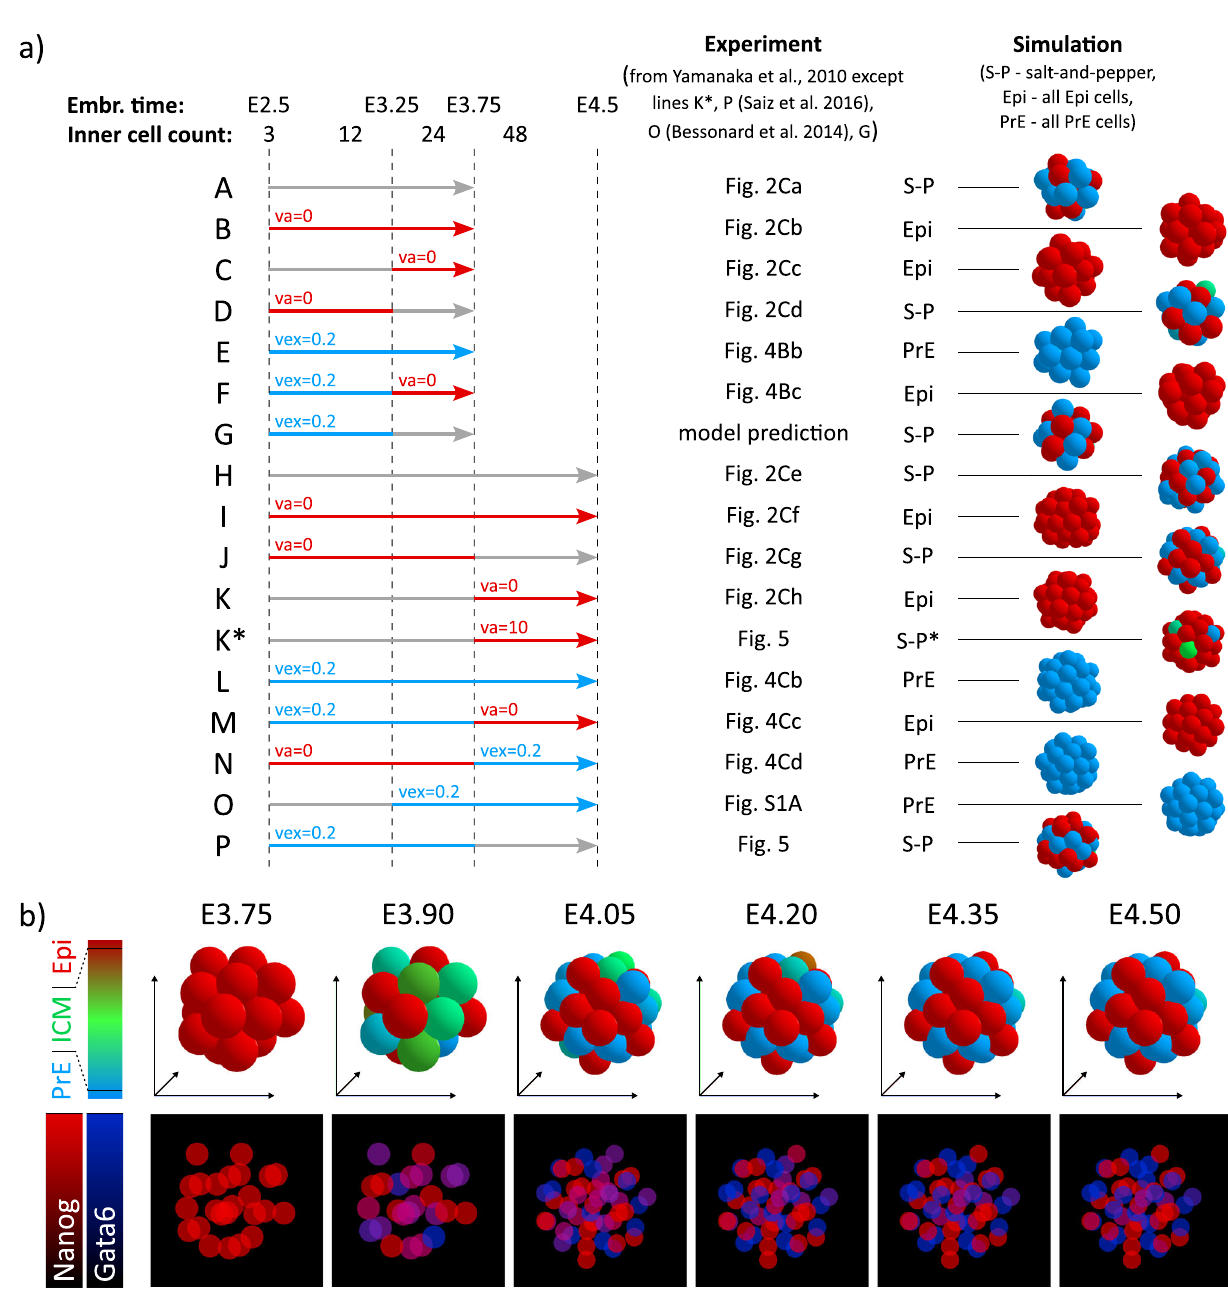
Fig. 5 a Results of different in silico treatments. Red lines denote the periods of the Erk-pathway inhibition ( va = 0, Eq. (3) in Fig. 1), whereas the blue lines denote the periods of addition of exogenous Fgf4 ( vex = 0.2, Eq. (5) in Fig. 1). For each in silico experiment (A to P), we show the reference to the corresponding experiment, and the simulation outcome. Line K* corresponds to a partial inhibition of the Erk-pathway, i.e., va = 10. b Embryo evolution in the experiment J for the period from E3.75 to E4.5. The top row shows the embryo snapshots during the evolution, whereas the bottom row shows the levels of Nanog and Gata6 at the corresponding